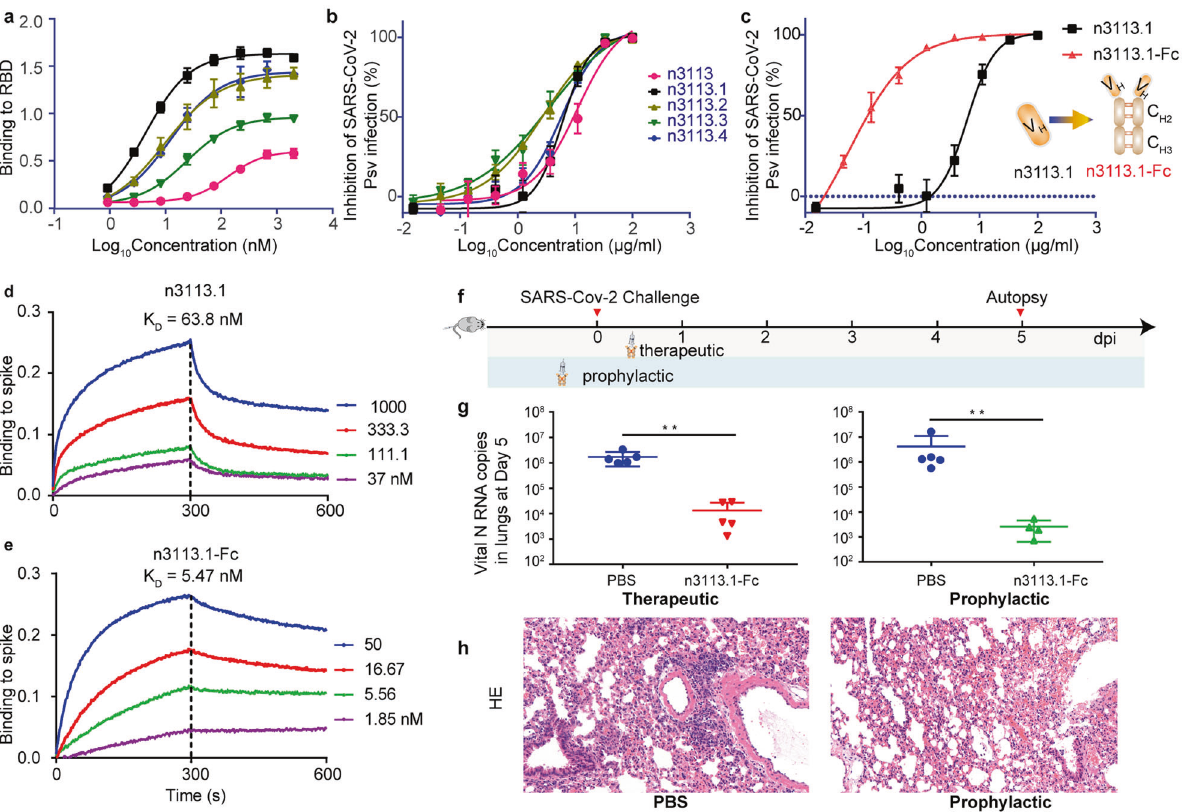
Fig. 1 Human single-domain antibody shows therapeutic value against SARS-CoV-2. a Binding af fi nity of n3113 and its variants with SARS- CoV-2 RBD. The mean ± SD from three independent experiments is shown. b Neutralization of SARS-CoV-2 S pseudovirus by n3113 and its variants. The mean ± SD from three independent experiments is shown. c Schematic representation of the generation of n3113.1-Fc and in vitro SARS-CoV-2 S pseudovirus neutralizing activity of n3113.1 and n3113.1-Fc. Neutralizing activities are presented as mean ± SD from three independent experiments. d – e Binding kinetic of n3113.1 ( d ) and n3113.1-Fc ( e ) with immobilized prefusion S ectodomain, measured using bio-layer interferometry (BLI). Dissociation constant (K D ) values for n3113.1 and n3113.1-Fc were obtained using a 1:1 binding model and 1:2 bivalent model, respectively. The experiments were performed in duplicate with similar results and a representative experiment is shown. f Schematic diagram of n3113.1-Fc treatment in SARS-CoV-2-susceptible mice. g Viral N RNA copies in the therapeutic group and the prophylactic group in the lungs were measured 5 dpi by qRT-PCR. P value was estimated by unpaired t test (** P < 0.01). h Histopathological characterization of the lungs of SARS-CoV-2 infected mice received prophylactic treatment of PBS or